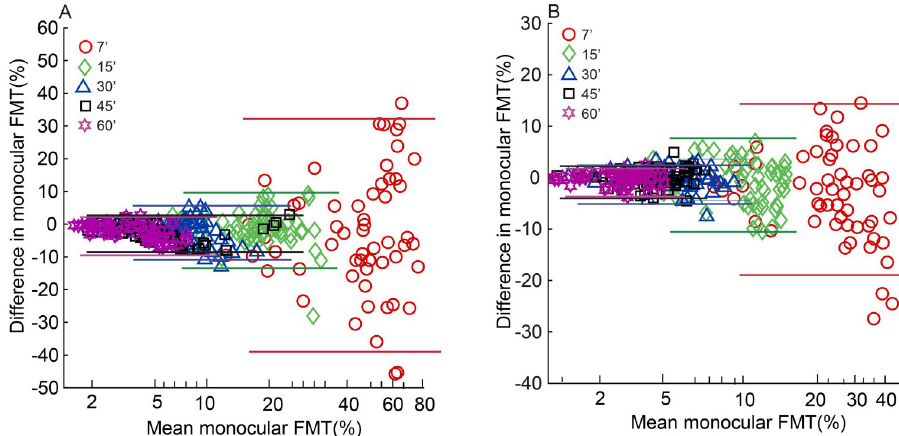
Fig 7. Bland-Altman plots of interocular difference in monocular FMTs plotted as a function of the corresponding mean FMT for the mesopic (panel A) and photopic viewing conditions (panel B). All other details are same as the Bland-Altman plots shown in Fig